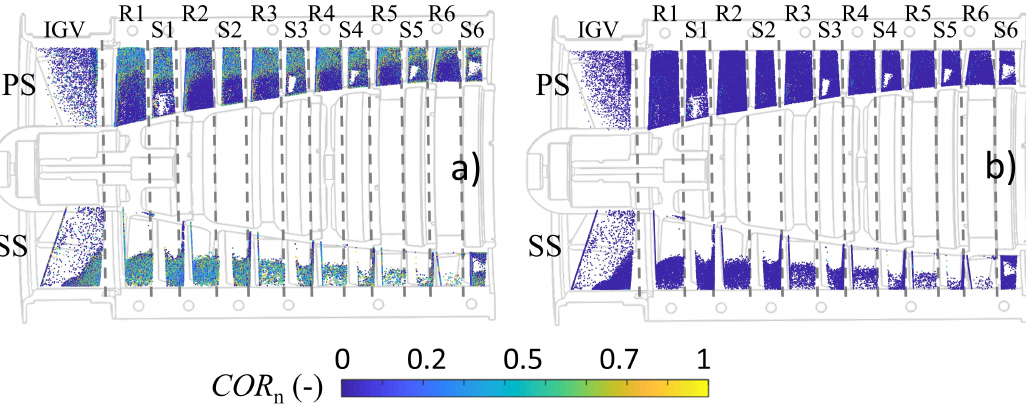
Figure 12. COR n calculated over the compressor stages for (a) γ = 0.1 N/m and (b) γ = 0.4